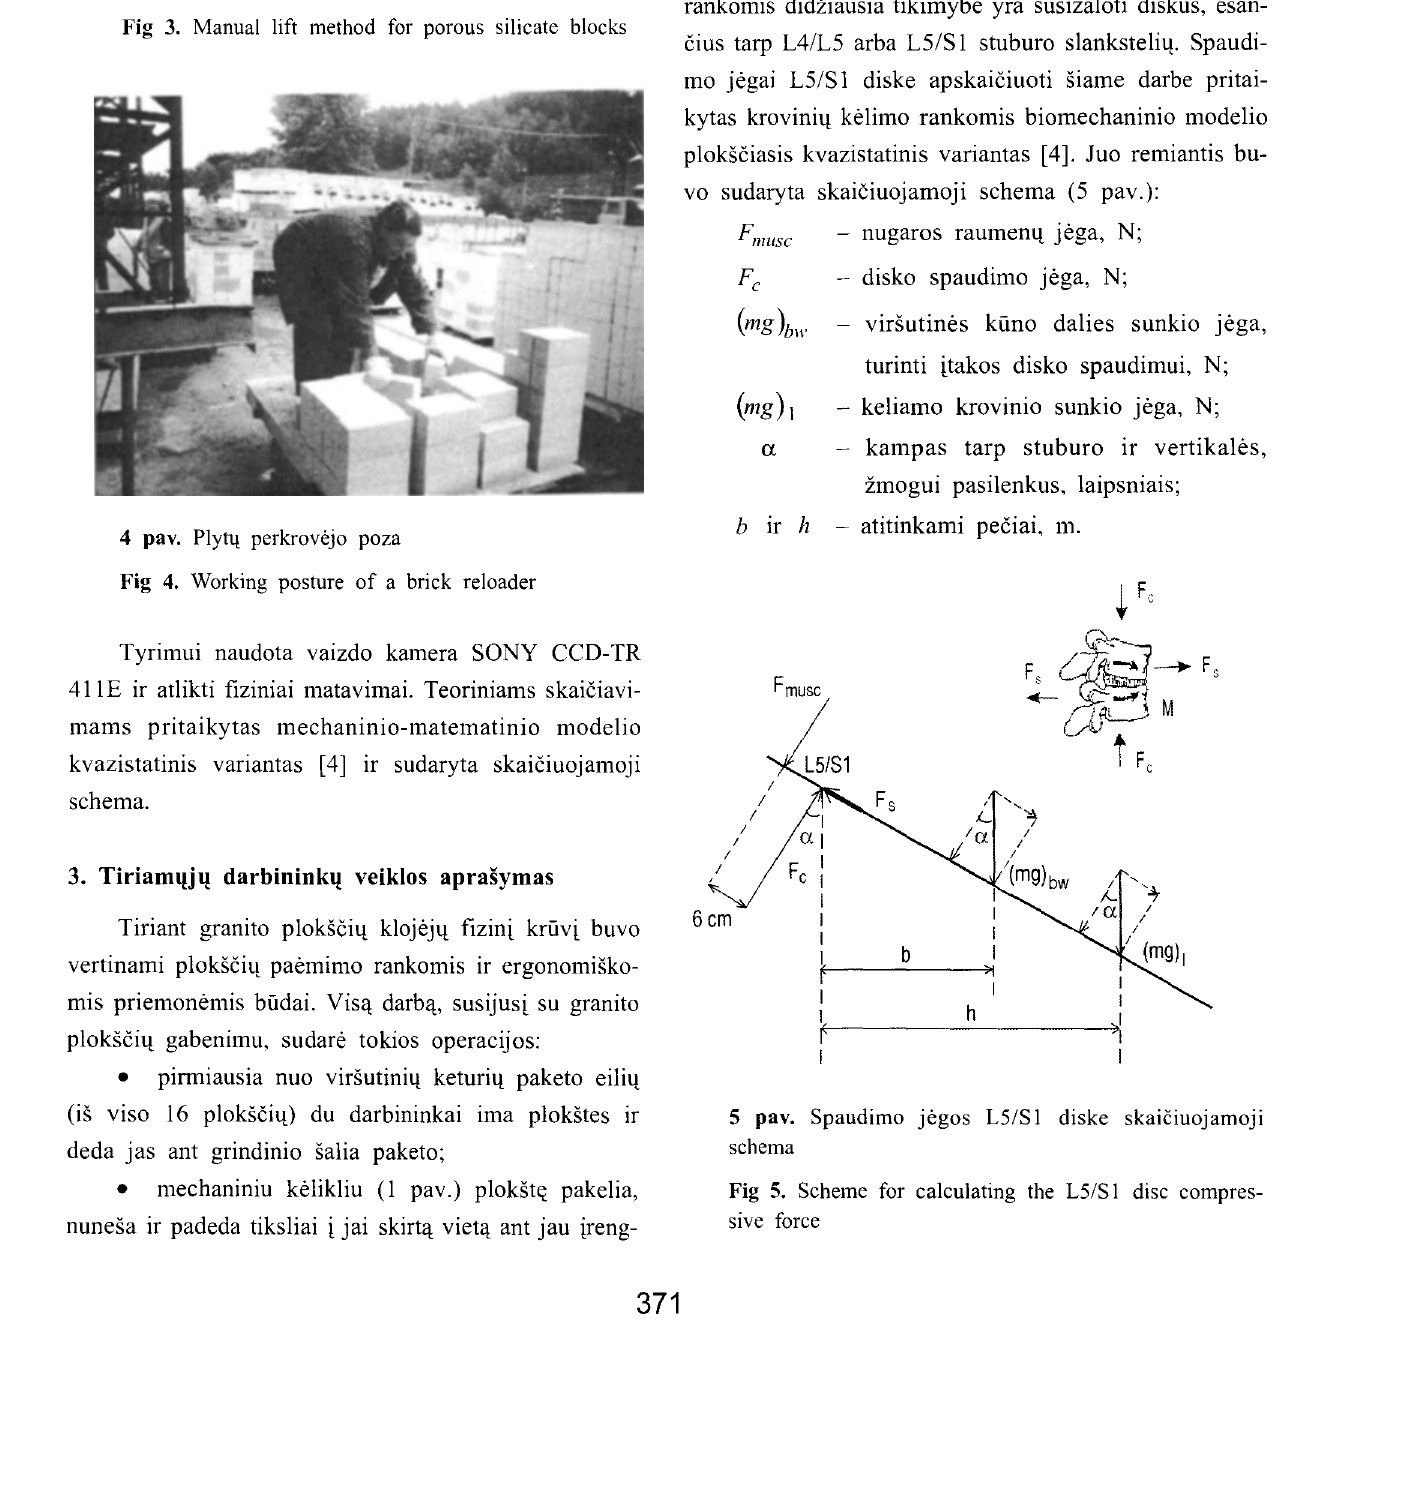
Fig 3. Manual lift method for porous silicate blocks